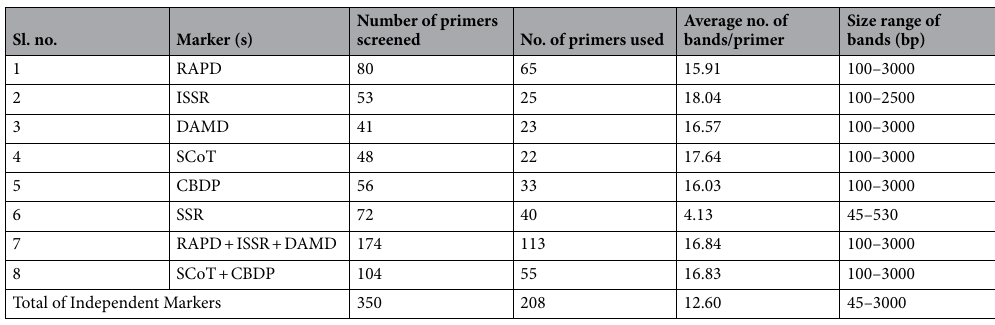
Table 2. Estimates of comparative performance of individual and cumulative DNA marker techniques applied to selected Indian mango genotypes.